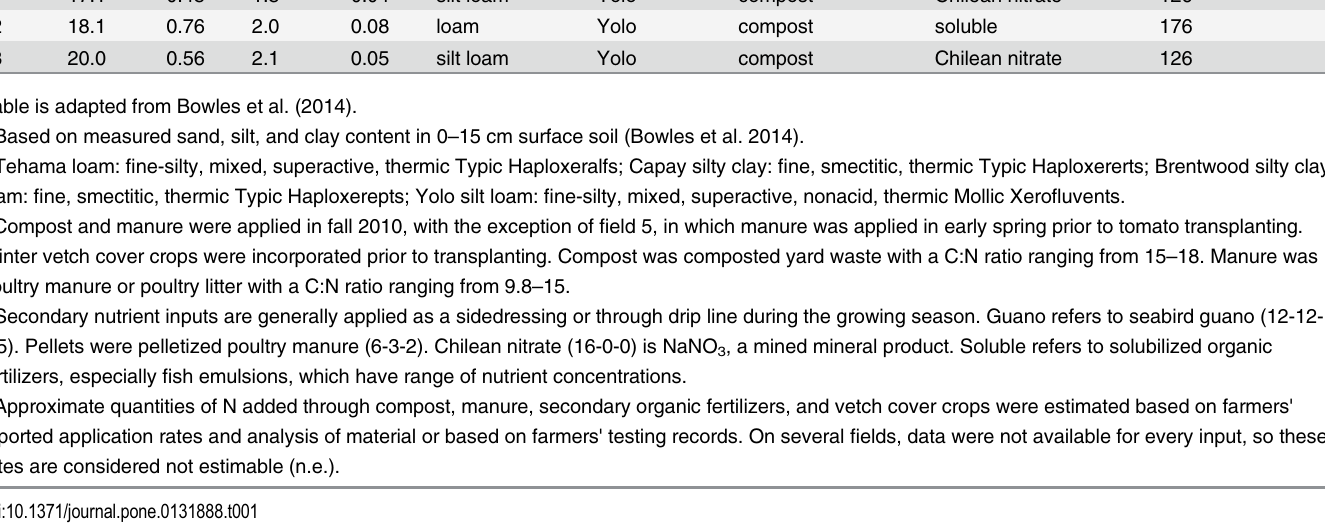
Table is adapted from Bowles et al. (2014).